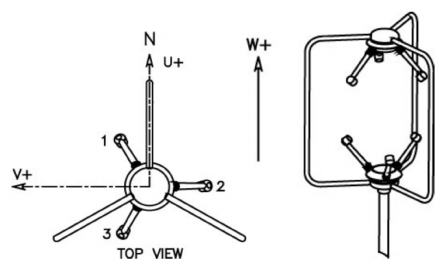
Figure 3. Tri-axial ultrasonic anemometer and the direction of the three instantaneous wind speed components (GILL WindMaster